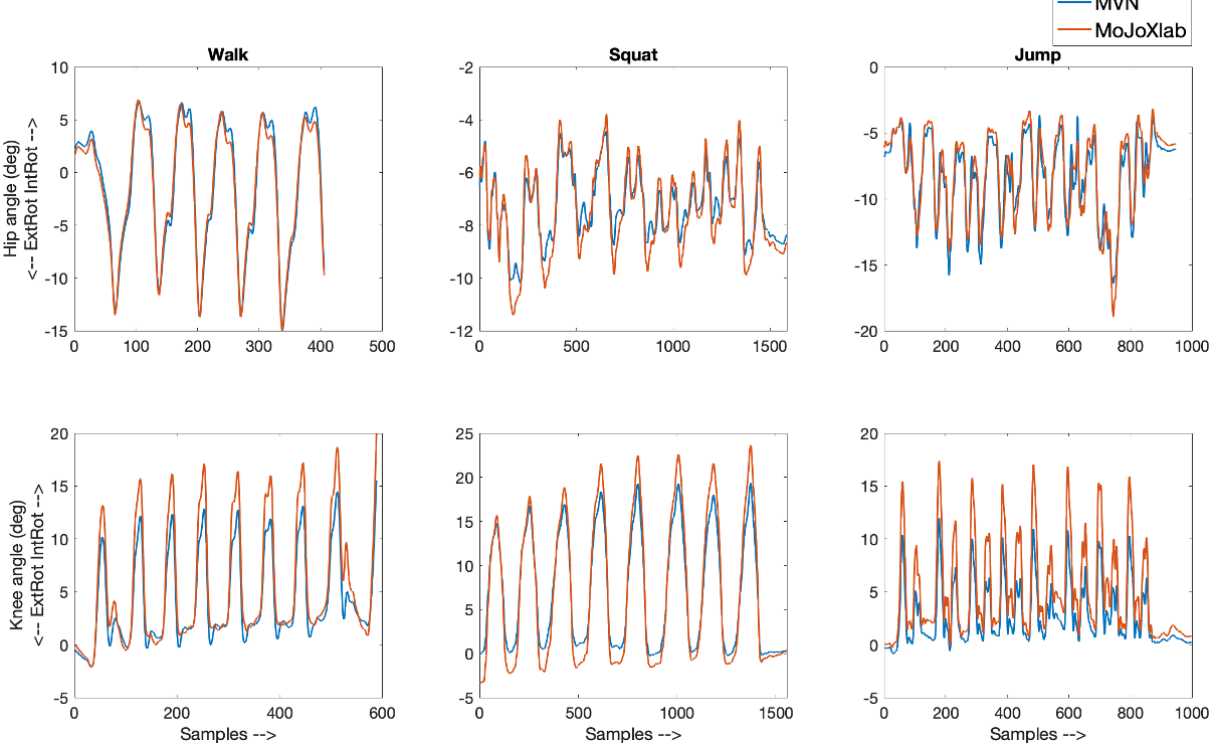
Figure 4. Representative transverse plane joint angle waveforms from the healthy participant data set. Waveforms for the hip (top row) and knee (bottom row) joint angles obtained from MVN Analyze (blue) and our custom software MoJoXlab (orange) for walking (left), squatting (center), and jumping (right) tasks. The y-axis represents joint angles in degrees, and the x-axis represents data samples across the entire